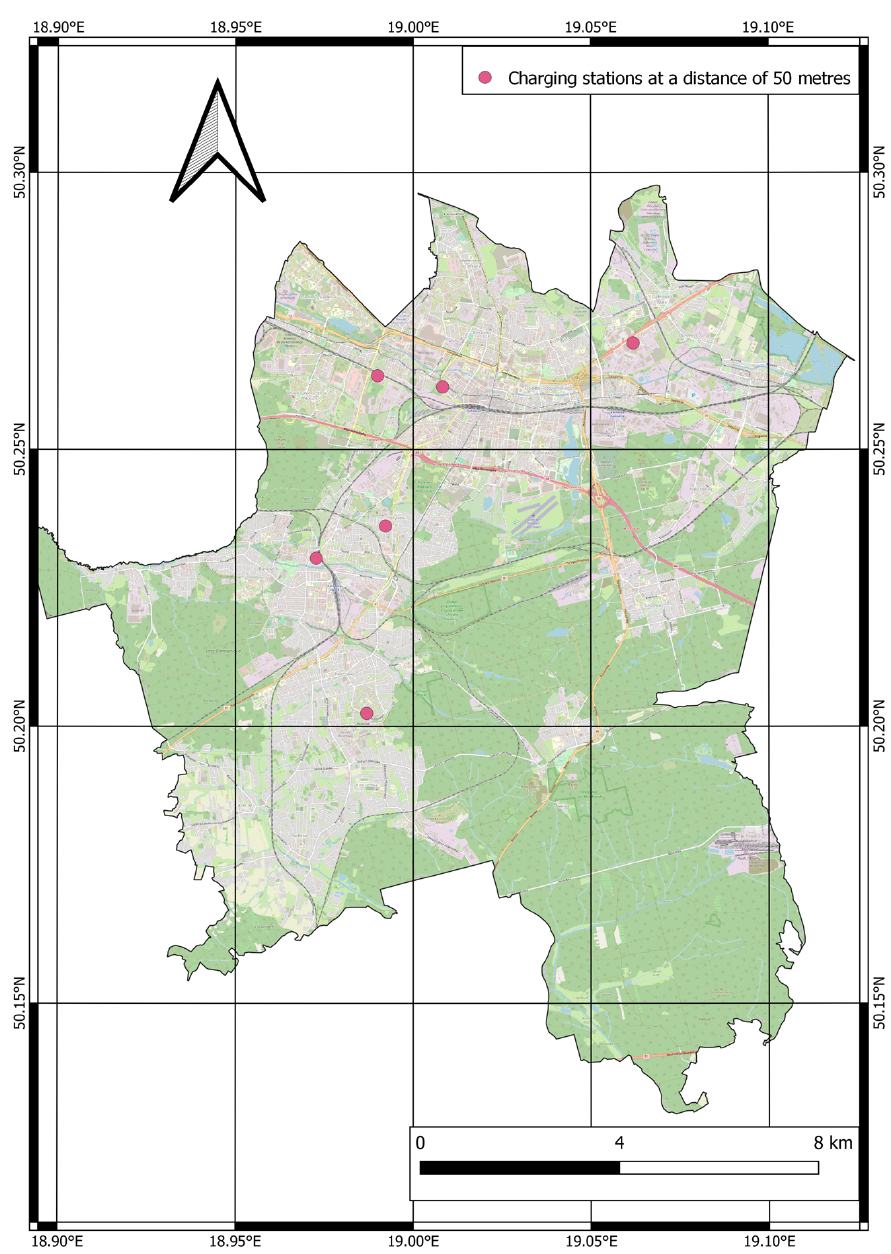
Figure 4. Charging stations within a distance of less than 50 m from a parcel pick-up and drop-off point.